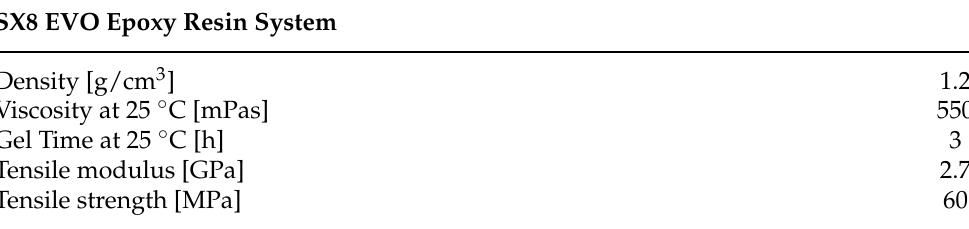
Table 1. Some datasheet information of the used epoxy resin